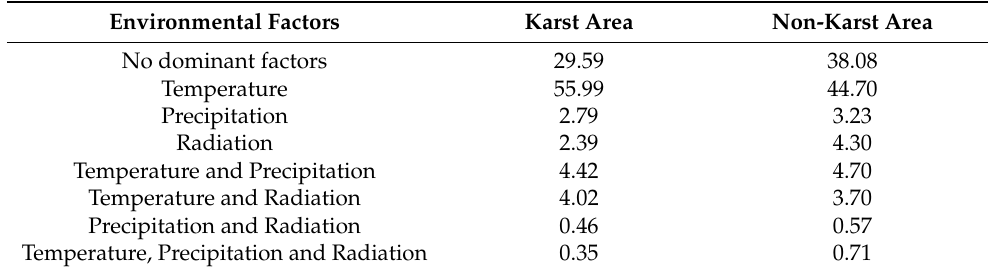
Table 4. Comparison of the area proportion in driving factors between the karst area and non-karst area over Southwest China from 1982 to 2015.